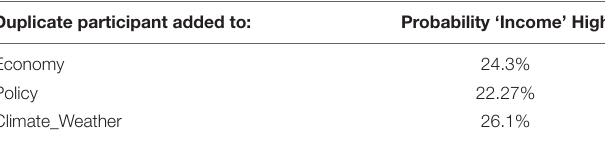
TABLE 5 | Results from the sensitivity testing where duplicate participants were added to the combined net in three separate runs. Duplicate participant added